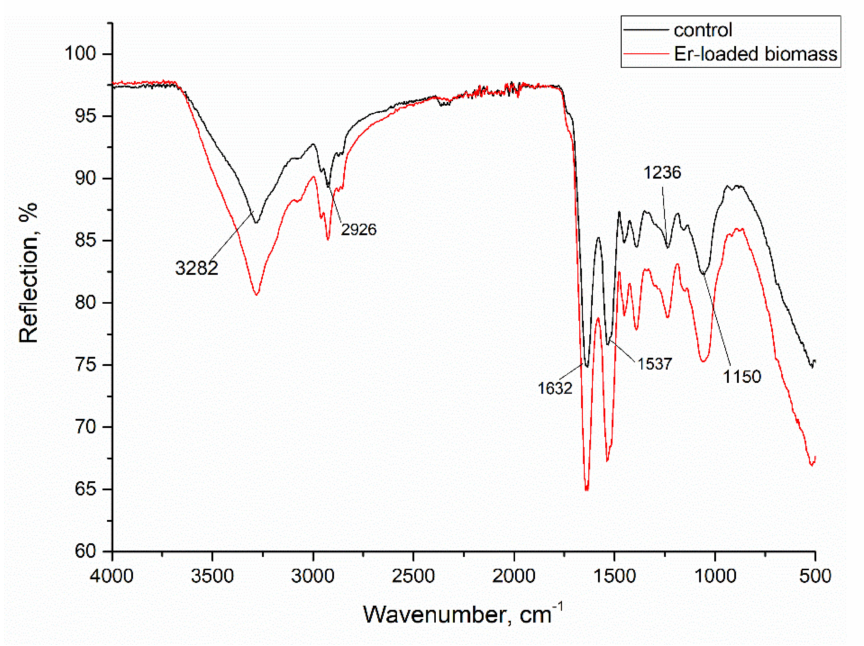
Figure 2. FTIR spectrum of A. platensis